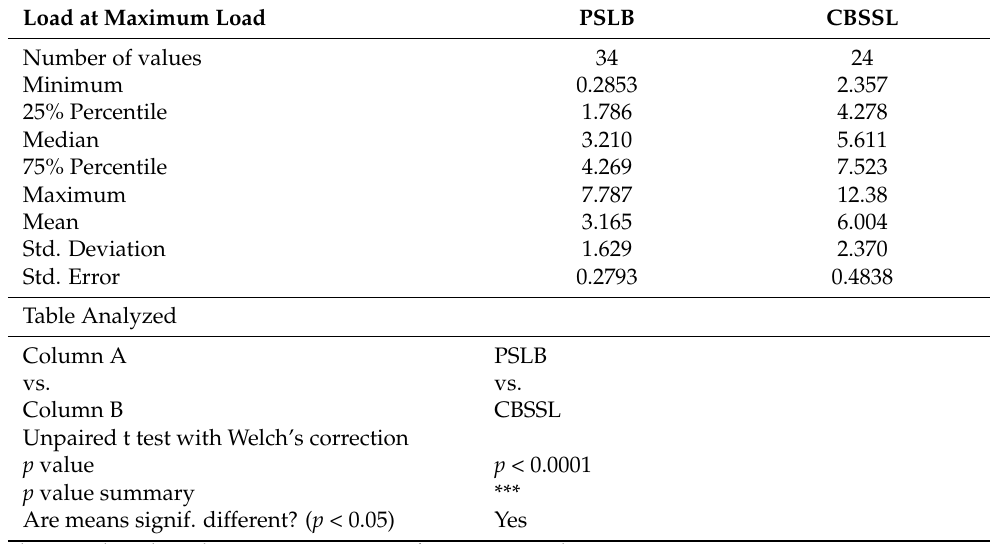
Table A12. Load at maximum load: passive self-ligating vs. conventional with stainless steel